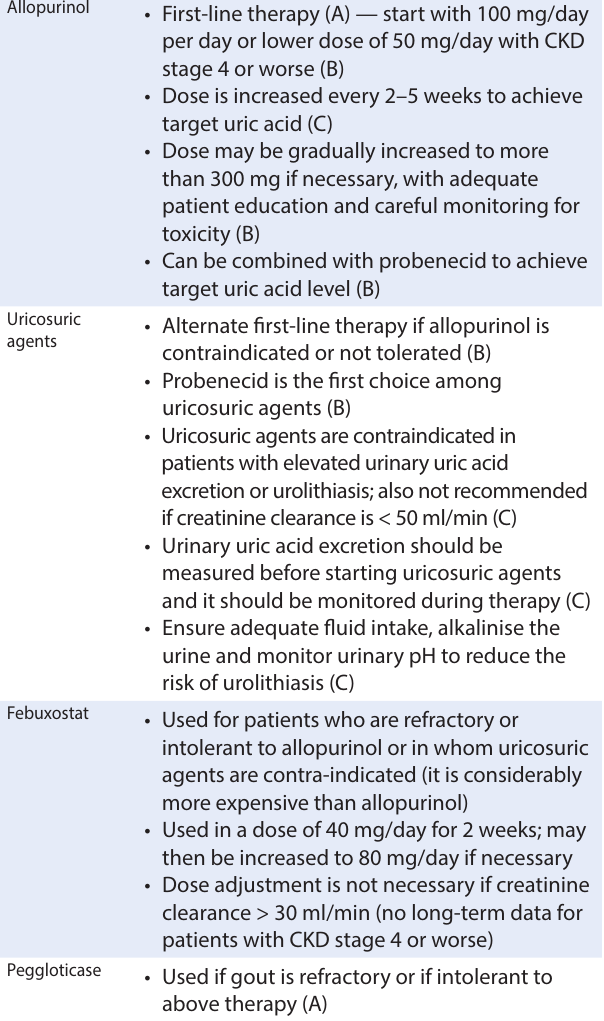
Table 2: Use of urate lowering therapy in patients with gout (level of evidence in brackets) 7